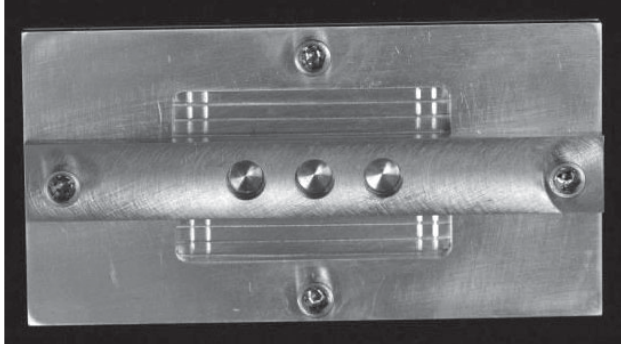
Fig. 1 – Matrix: 1- base with in line cylinders (3.75mm diameter x 4 mm height). 2: component with central opening level with the height of the cylinders. 3: rectangular bar with 3 holes coinciding with the location of the cylinders. Lateral screws to keep the three components